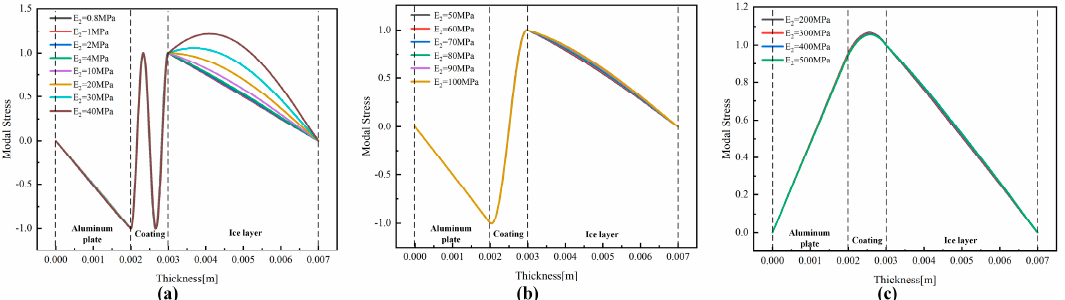
Figure 6. Shear stress ( σ 31 ) wave structure of Lamb waves corresponding to the maximum ISCC for different Young’s moduli of coating: ( a ) 0.8 MPa–40 MPa (all wave structures belong to S 3 mode); ( b ) 50 MPa–100 MPa (all wave structures belong to the S 2 mode); ( c ) 200 MPa–500 MPa (all wave structures belong to A 1 mode).